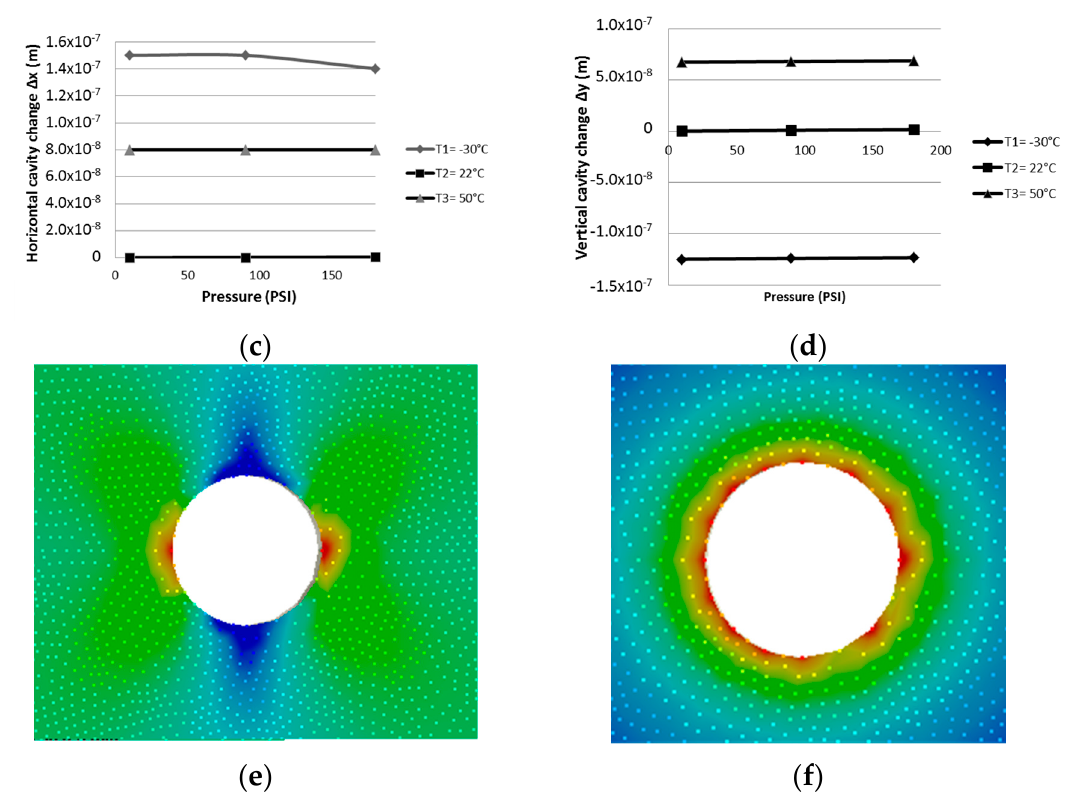
Figure 11. Dimensional differences with the presence of p c and p t in ( a ) the horizontal side of the cavity ( Δ x), ( b ) the vertical side ( Δ y), ( c ) Δ x when p t is eliminated, ( d ) Δ y when p t is eliminated, ( e ) the stress distribution around the cavity when p c and p t is present and ( f ) the stress distribution around the cavity when p t is eliminated.